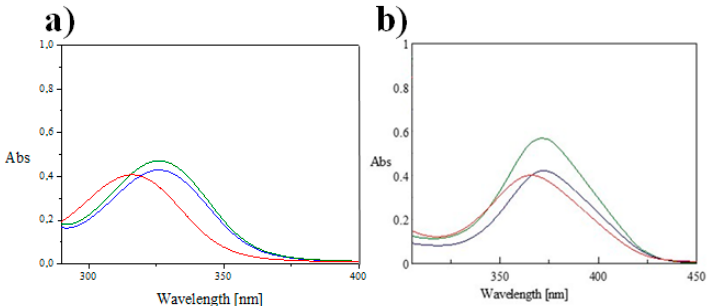
Figure 7. ( a ) UV–Vis spectra of Oligo–Salen–A (red), Oligo–Salen–B (blue), and Oligo–Salen–C (green) in DMSO (4 × 10 − 5 M); ( b ) Zn–Oligo–A (red), Zn–Oligo–B (blue), and Zn–Oligo–C (green) in